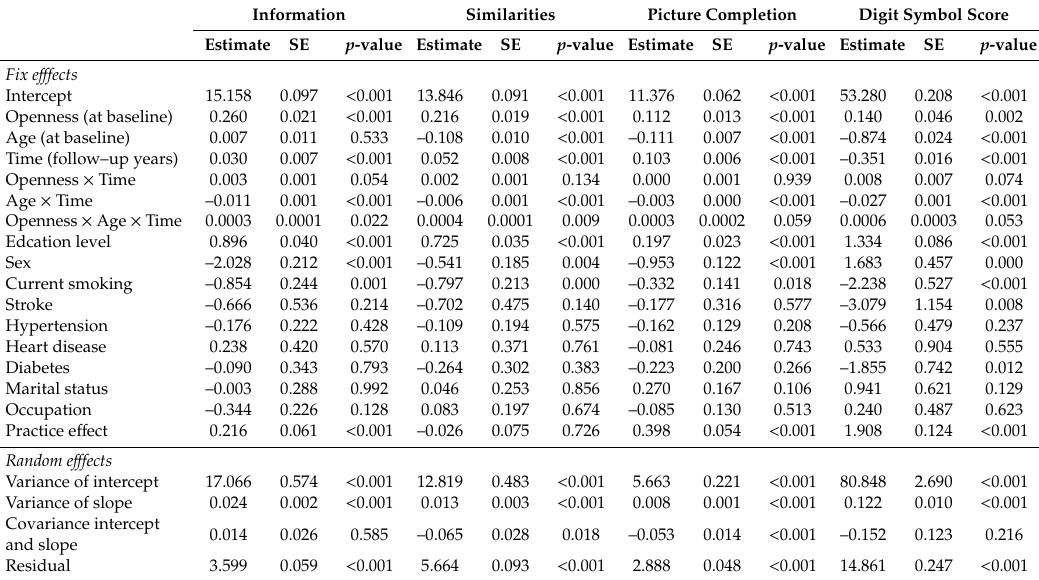
Table 3. General linear mixed model parameter estimates for cognitive